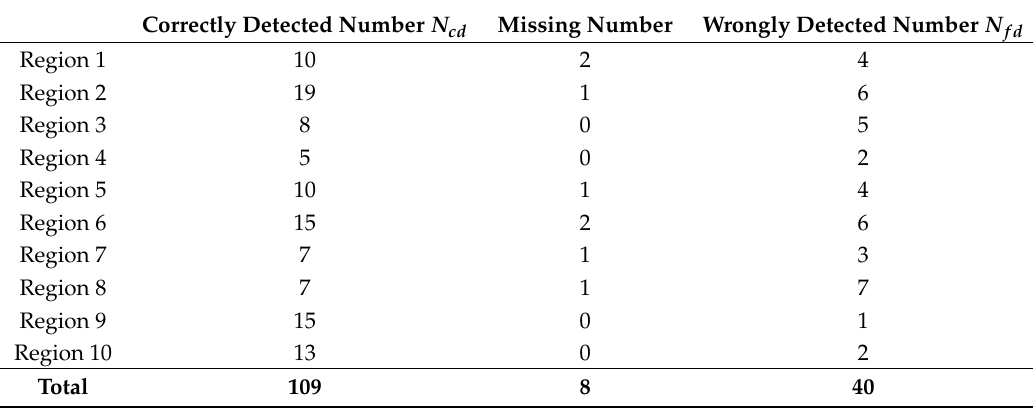
Table 2. The detection number of the CFAR